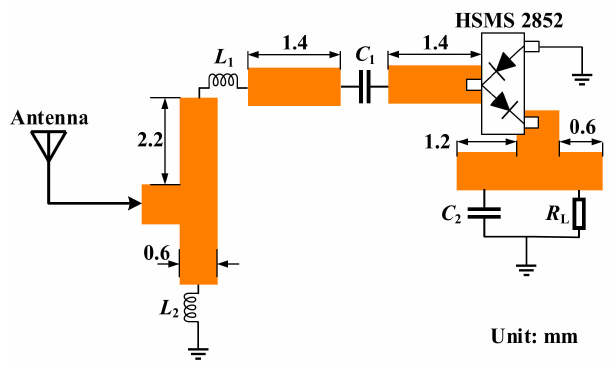
Figure 13. Schematic of the rectifier circuit. The parameters are: L 1 = 18 nH, L 2 = 5.1 nH, C 1 = 100 pF, C 2 = 330 pF, and R L = 4.3 k Ω .